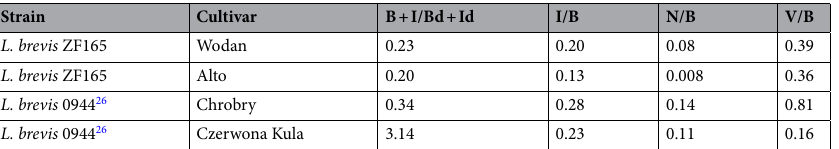
Table 2. Comparison of betalains changes after fermentation expressed by betanin + isobetanin/ betanidin + isobetanidin, B + I/Bd + Id, isobetanin/betanin, I/B, neobetanin/betanin, N/B, and vulgaxanthin I/ betanin, V/B, ratios for fermented red beetroots of varied cultivars grown in